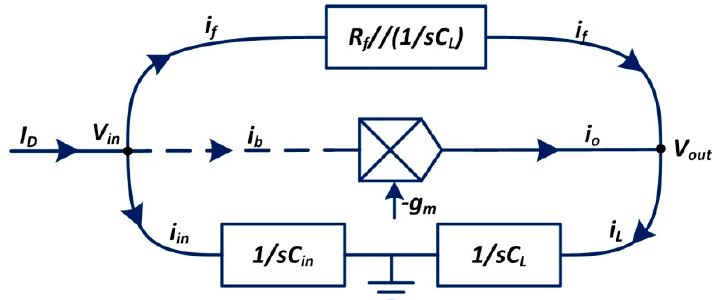
Figure 6. Schematic drawing of the CSA. The oscillogram in the red dotted box at the top left shows several narrow pulses of input current and long-tail pulses with a duration of R f C f in the red dotted box at the top right. Once a pulse of induced charge from MCP output appears on the virtual ground node, the step voltage at the CSA output is created by the feedback capacitor C f as a result of the feedback operation. Afterwards, the charged capacitor C f can be reset by the feedback resistor R f until the next event arrives. An exponential decay follows the output voltage’s peak point, while the feedback